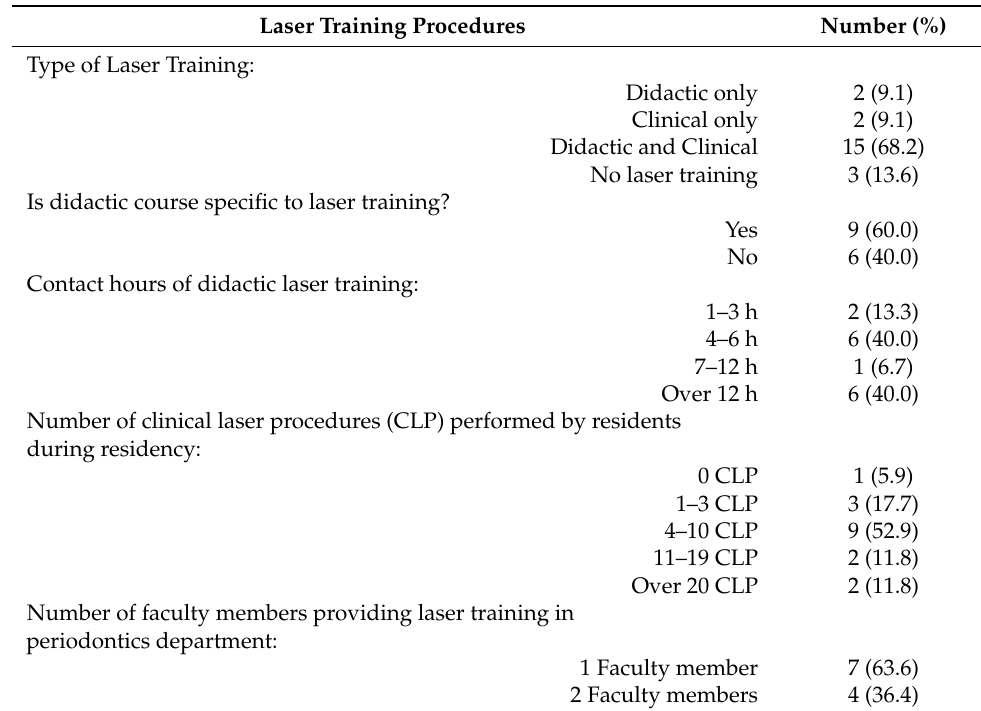
Table 3. Laser training in periodontics departments in the U.S. and Canada.